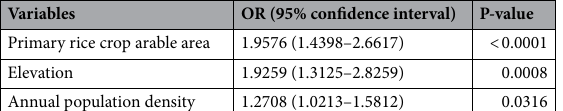
Table 2. Results of the final generalized linear mixed model for annual reported cases. OR odds ratio.